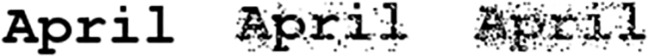
Experiment 2: Magnified depiction of visual degradation.Visual degradation was realized by pixel displacement. From left to right, the figure shows examples of 0%, 10% and 20% of pixel displacements, that is, parafoveal previews with high to low salience.